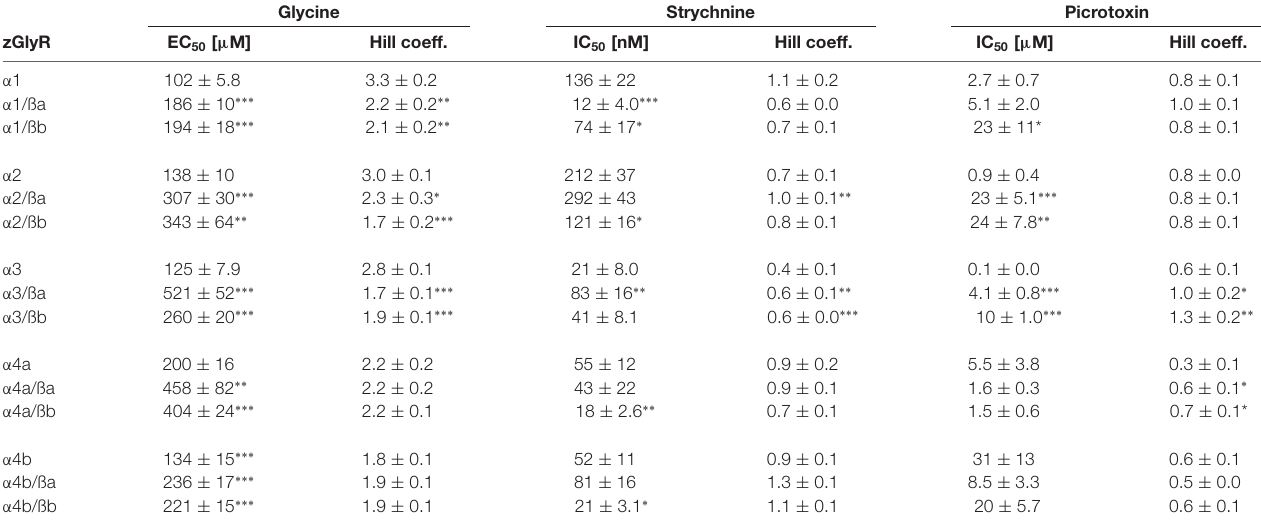
TABLE 2 | Summary of homomeric and heteromeric zGlyR properties. Glycine Strychnine Picrotoxin zGlyR EC 50 [ µ M] Hill coeff. IC 50 [nM] Hill coeff. IC 50 [ µ M] Hill